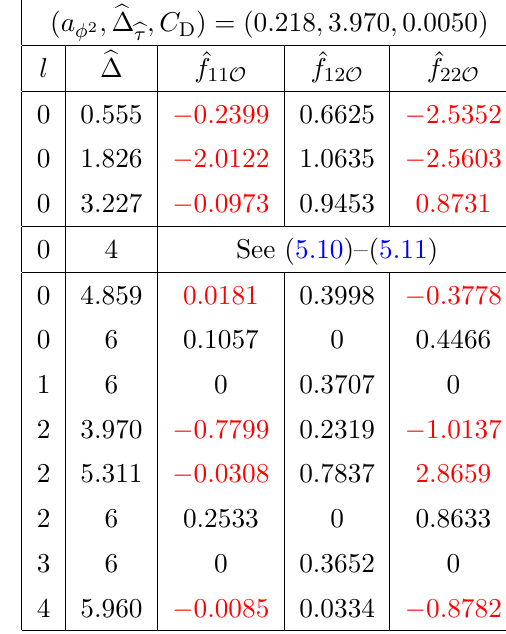
Table 2. The low-lying spectrum at two points in ( a the left table is still visible after projecting down to just ( a to our maximization choice, we see every possible operator with odd spin. Protected operators (the ones with integer scaling dimensions) of even spin have vanishing mixed OPE coefficients and they start above the leading twist. Unprotected operators have their OPE coefficients related by (2.22) and thus we have shown calculated values in